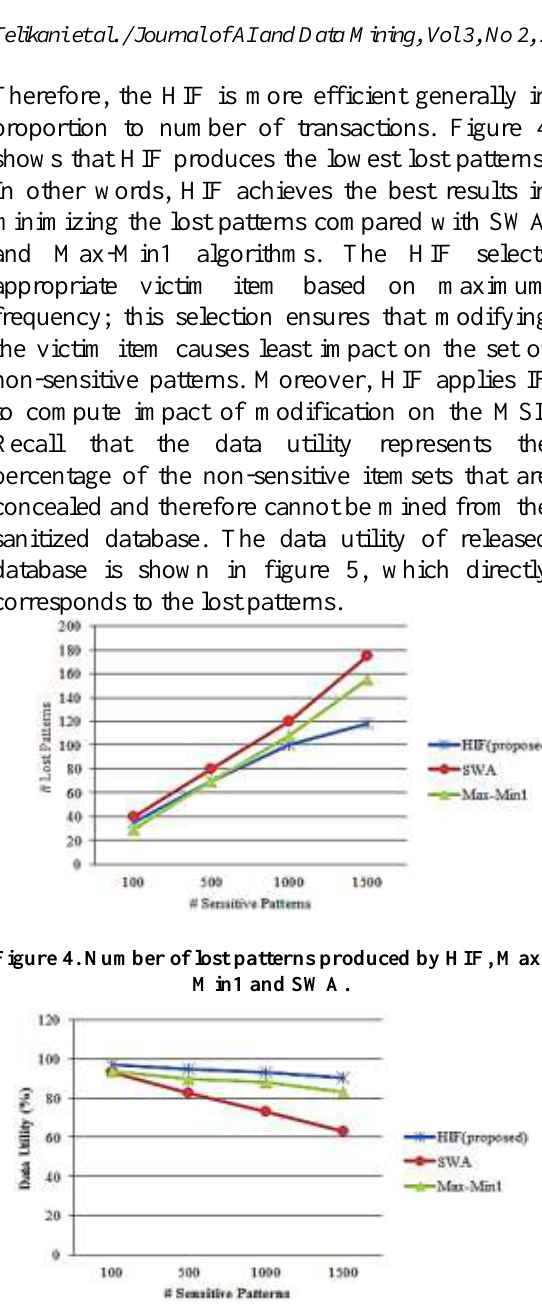
Figure 5. Data utility of dataset produced by HIF, Max- Min1 and SWA.